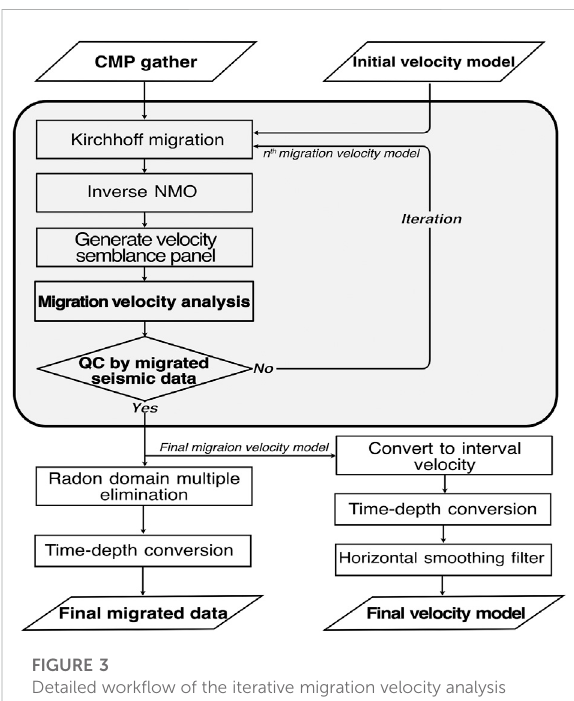
FIGURE 3 Detailed work fl ow of the iterative migration velocity analysis to construct the seismic velocity